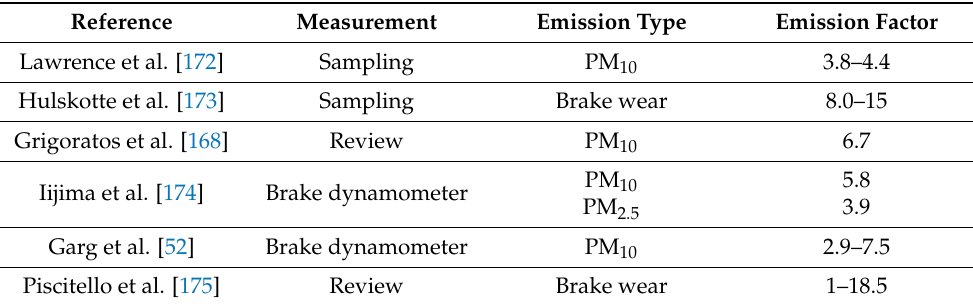
Table 4. Emission factors of vehicles reported in the literature for LDVs and passenger cars (mgkm − 1 vehicle − 1